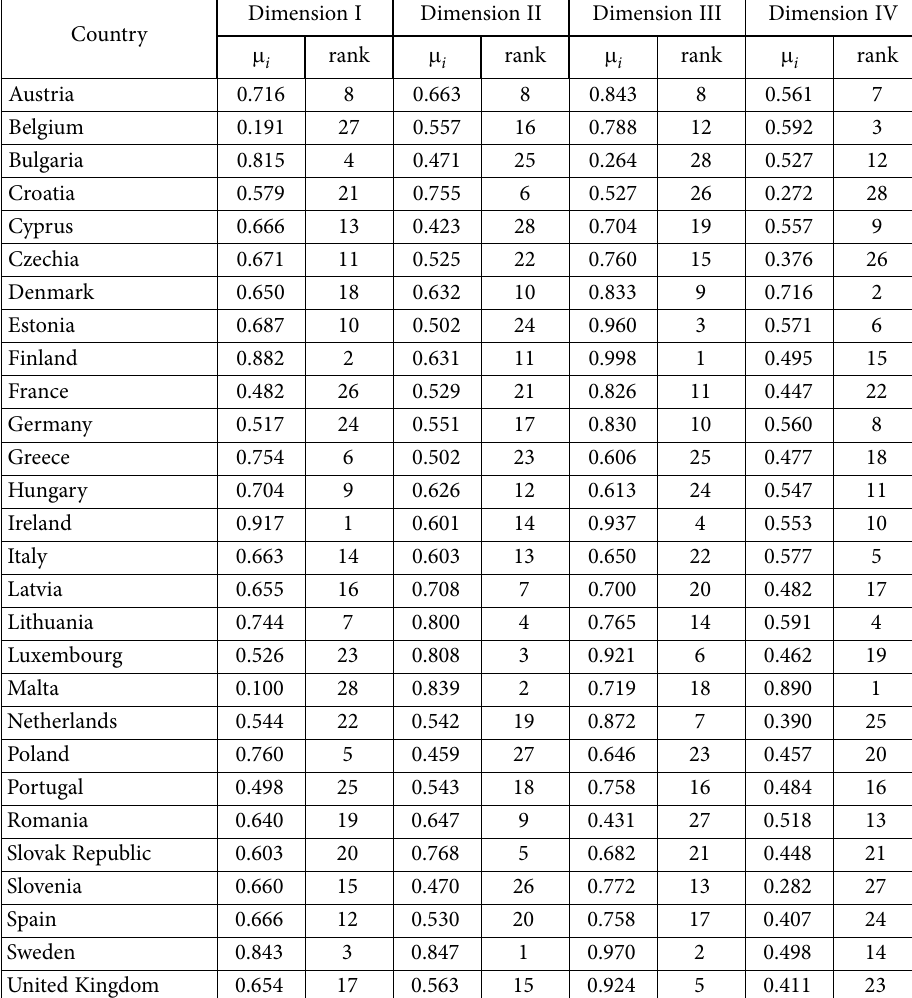
Table 7. Comparison of the results of the ordering of EU countries in 2019 Country